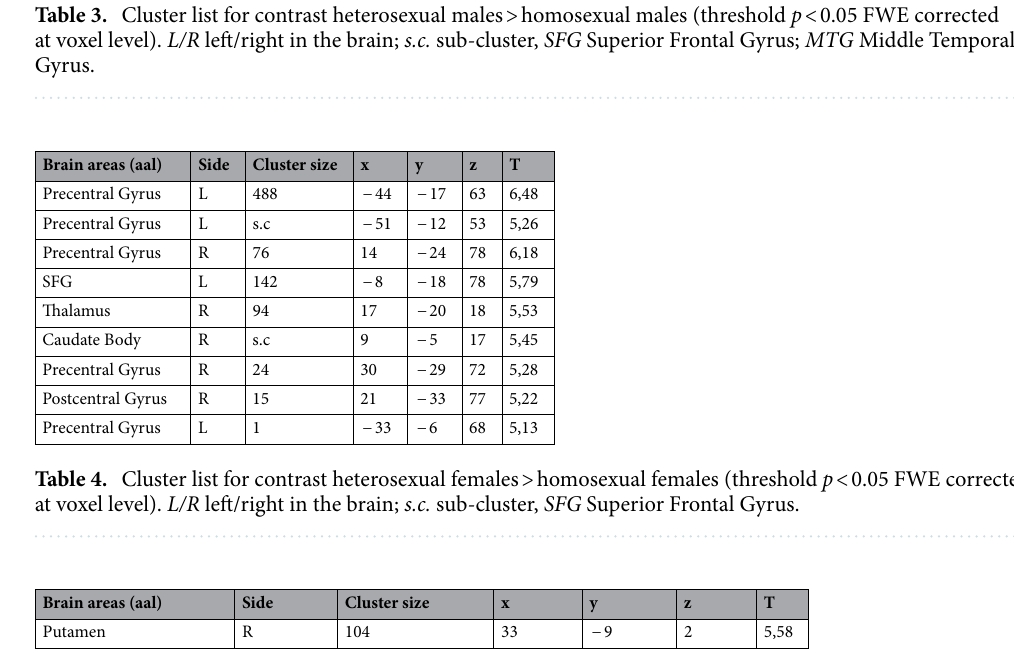
Table 5. Cluster list for contrast homosexual females > heterosexual females (threshold p < 0.05 FWE corrected at voxel level). L/R left/right in the brain.